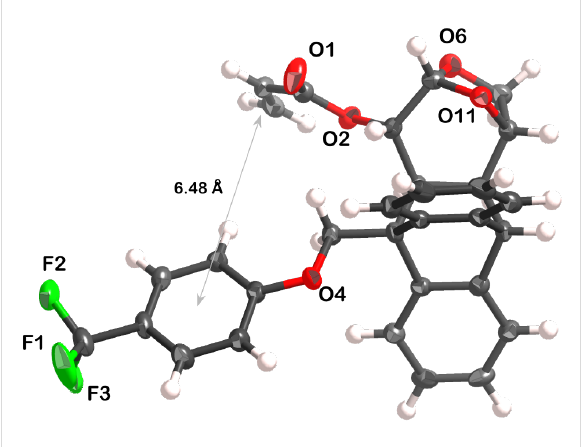
Figure 6: X-ray thermal ellipsoid plot of 6a (50% probability level) showing the labeling scheme (hydrogen and carbon labels have been omitted for